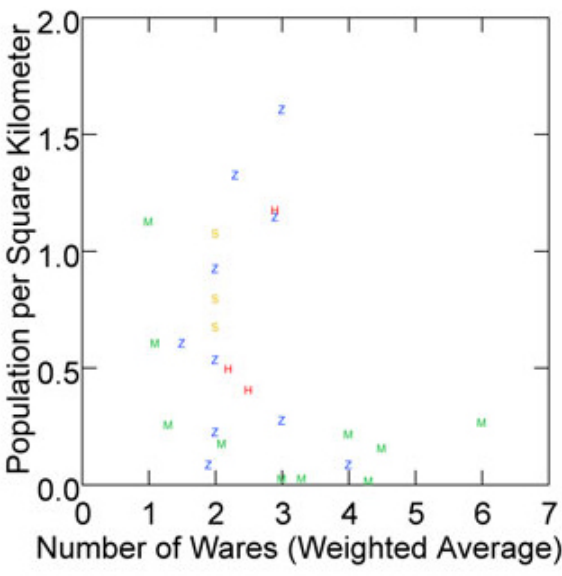
Fig. 10 . Population density and ceramic ware diversity values for all time-space units with densities below 3.0. Region indicated by letter and color. H = Hohokam, M = Mimbres, S = Salinas, Z =